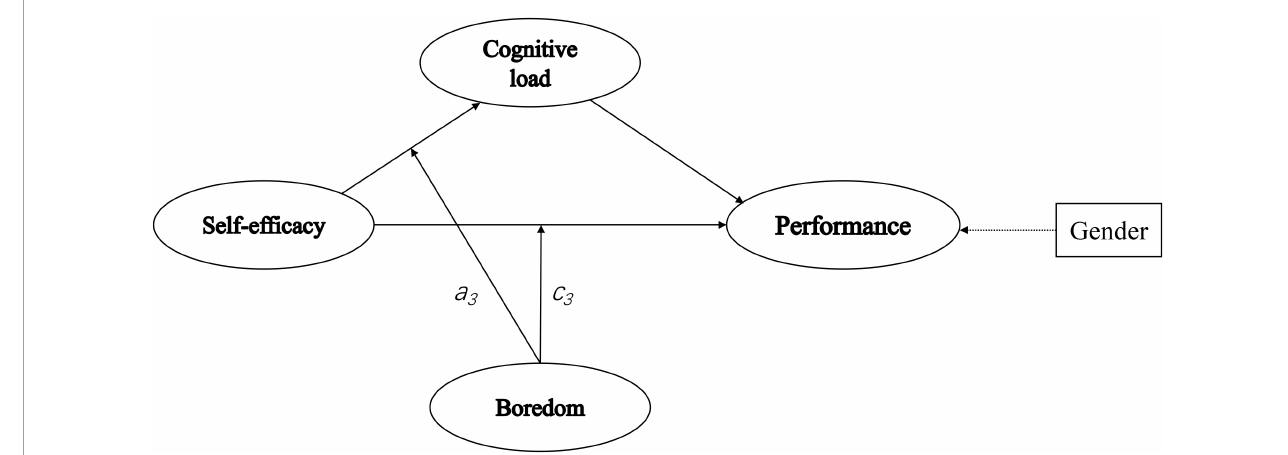
FIGURE2 Moderated-mediation model.